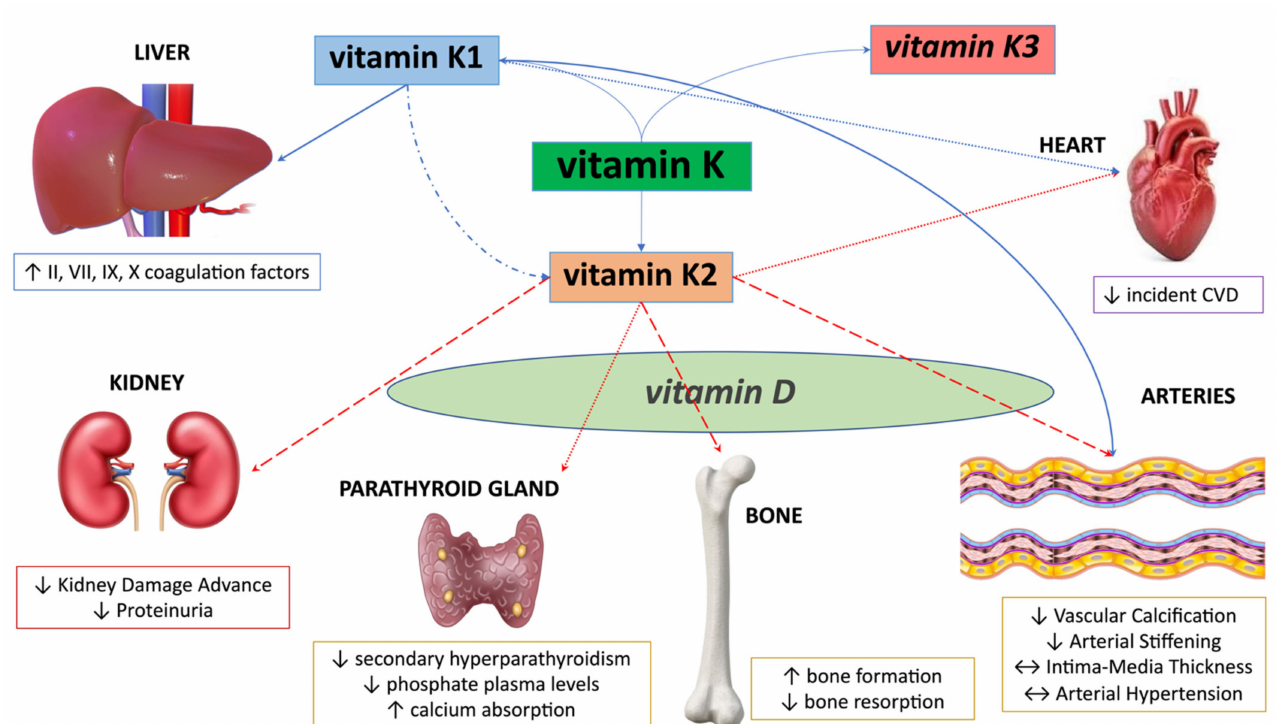
Figure 2. Vitamin K vitamers potential role on liver, kidney, parathyroid gland, bone, arteries, and heart. Potential synergism with vitamin D (on parathyroid, bone, and arteries) is also